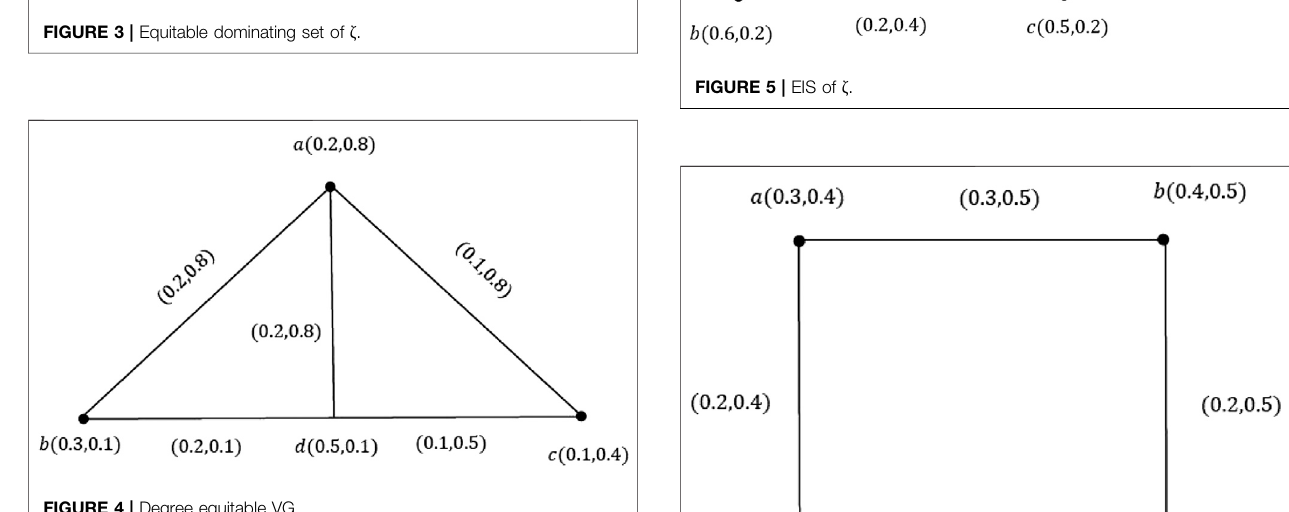
FIGURE 4 | Degree equitable VG.